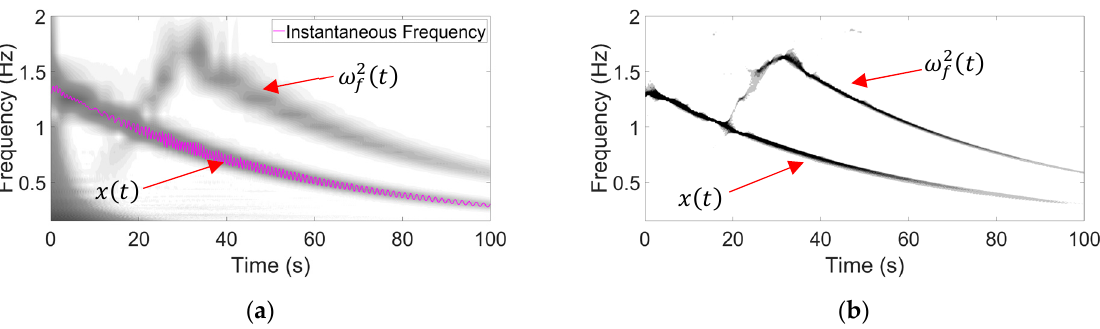
Figure 7. Time–frequency representation of 𝑥(𝑡) and 𝜔 (cid:3033)(cid:2870) (𝑡) : ( a ) wavelet transform; ( b ) SSAWT.